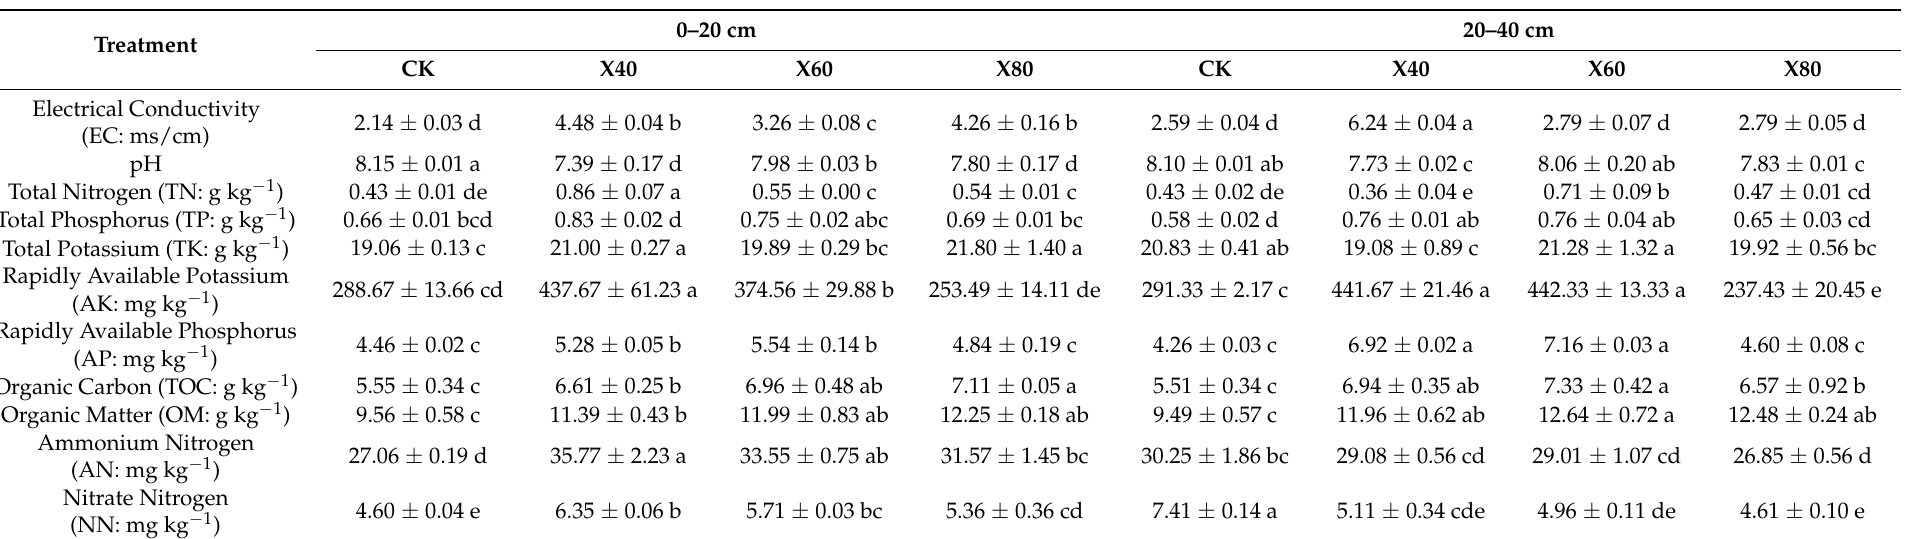
Table 3. Soil physicochemical properties in different root-restriction treatments and no root-restriction